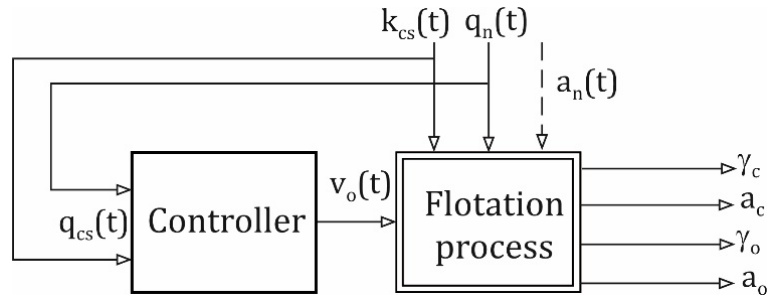
Figure 2. Automatic control of the coal flotation process with a constant reagent dose.